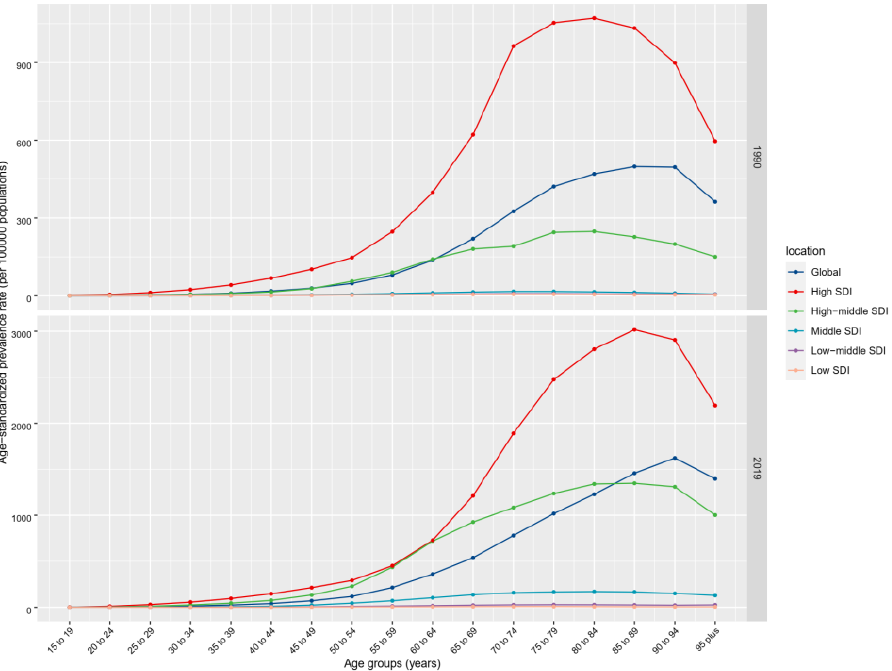
Figure 2. The ASPR of nrCAVD by age group in 1990 and 2017. ASPR, age-standardized prevalence rate; nrCAVD, non-rheumatic calcific aortic valve disease.